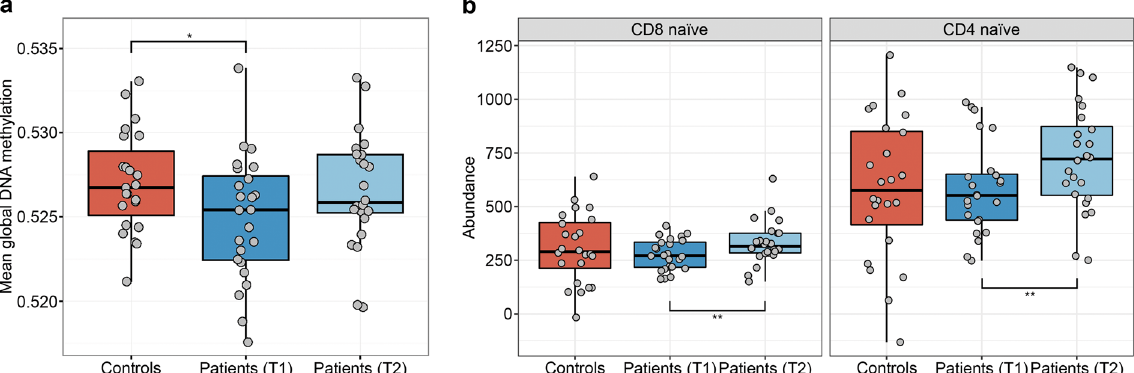
Figure 2. Mean global DNAm differences and naïve T-cell subtype differences between groups. ( a ) Patients (T1) showed significantly decreased mean global DNAm levels compared to controls (P = 0.048, Mann- Whitney U test). Differences between controls vs. patients (T2) and patients (T1) vs. patients (T2) were not significant. ( b ) Abundance levels of naïve CD8 + and CD4 + T-cells were predicted using an advanced blood DNA methylation age prediction tool. Both naïve T-cell subtypes significantly increased post-treatment in patients ( ** Indicates an FDR < 0.01, Wilcoxon signed-rank test) but were not significantly different between controls and patients at either time